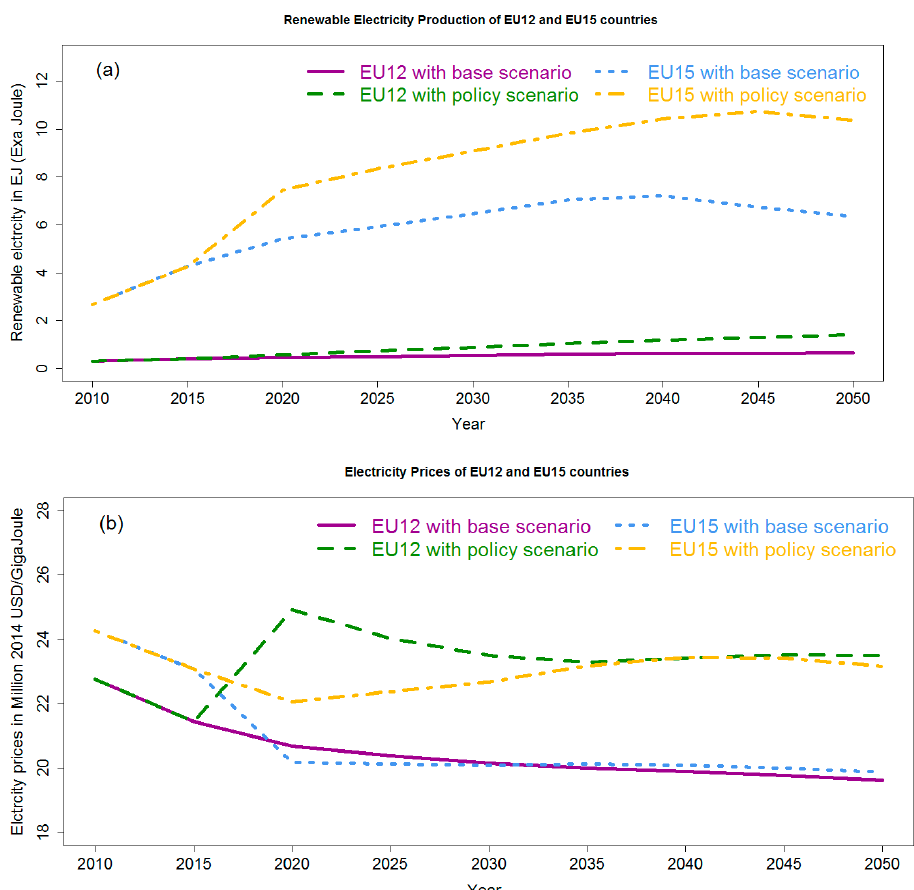
Figure 7. ( a ) Renewable electricity production of EU12 and EU15 countries, ( b ) Electricity prices of EU12 and EU15 countries for both base and policy scenarios. Here the model starts updating from 2015 (previous periods are given by default) and the policy scenario is activated in 2020 (i.e., 20% reduction by 2020 compare to 2005 level). Since the model runs with 5-year time steps, there is a sudden jump from 2015 to 2020.